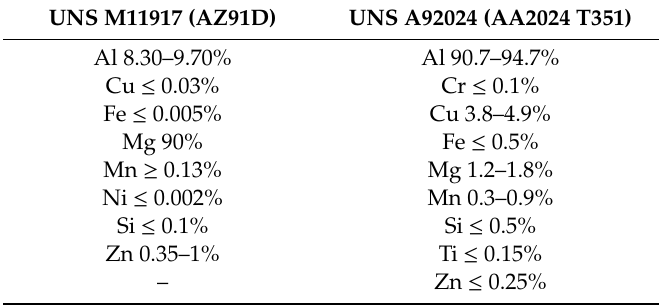
Table 3. Chemical composition of the materials used for the manufacturing specimens.